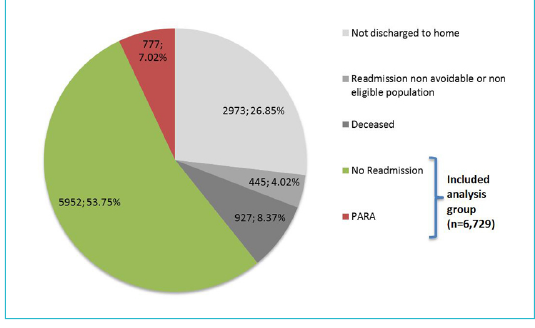
Figure 2: Situation at 30 days after discharge for all hospital stays in the CHUV Department of Internal Medicine (n = 11 074).PARA =